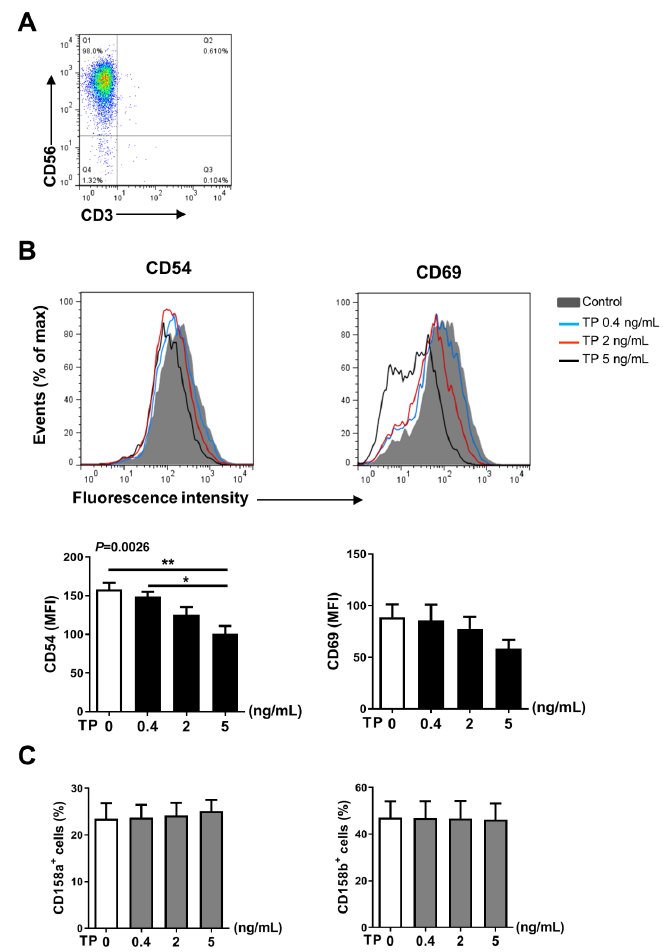
Figure 3. Effects of TP on the phenotype of human purified NK cell. ( A ) Human purified NK cells were isolated from human peripheral blood mononuclear cells by immunomagnetic negative sorting. ( B , C ) Purified NK cells were stimulated with TP as indicated (i.e., 0, 0.4, 2, and 5 ng/mL) for 24 h, the expression of the activating receptors CD54, CD69 ( B ) and the inhibitory receptors CD158a, CD158b ( C ) were measured by flow cytometry. Data were analyzed by one-way analysis of variance with a multiple comparisons test ( n = 4), * p < 0.05, ** p < 0.01.